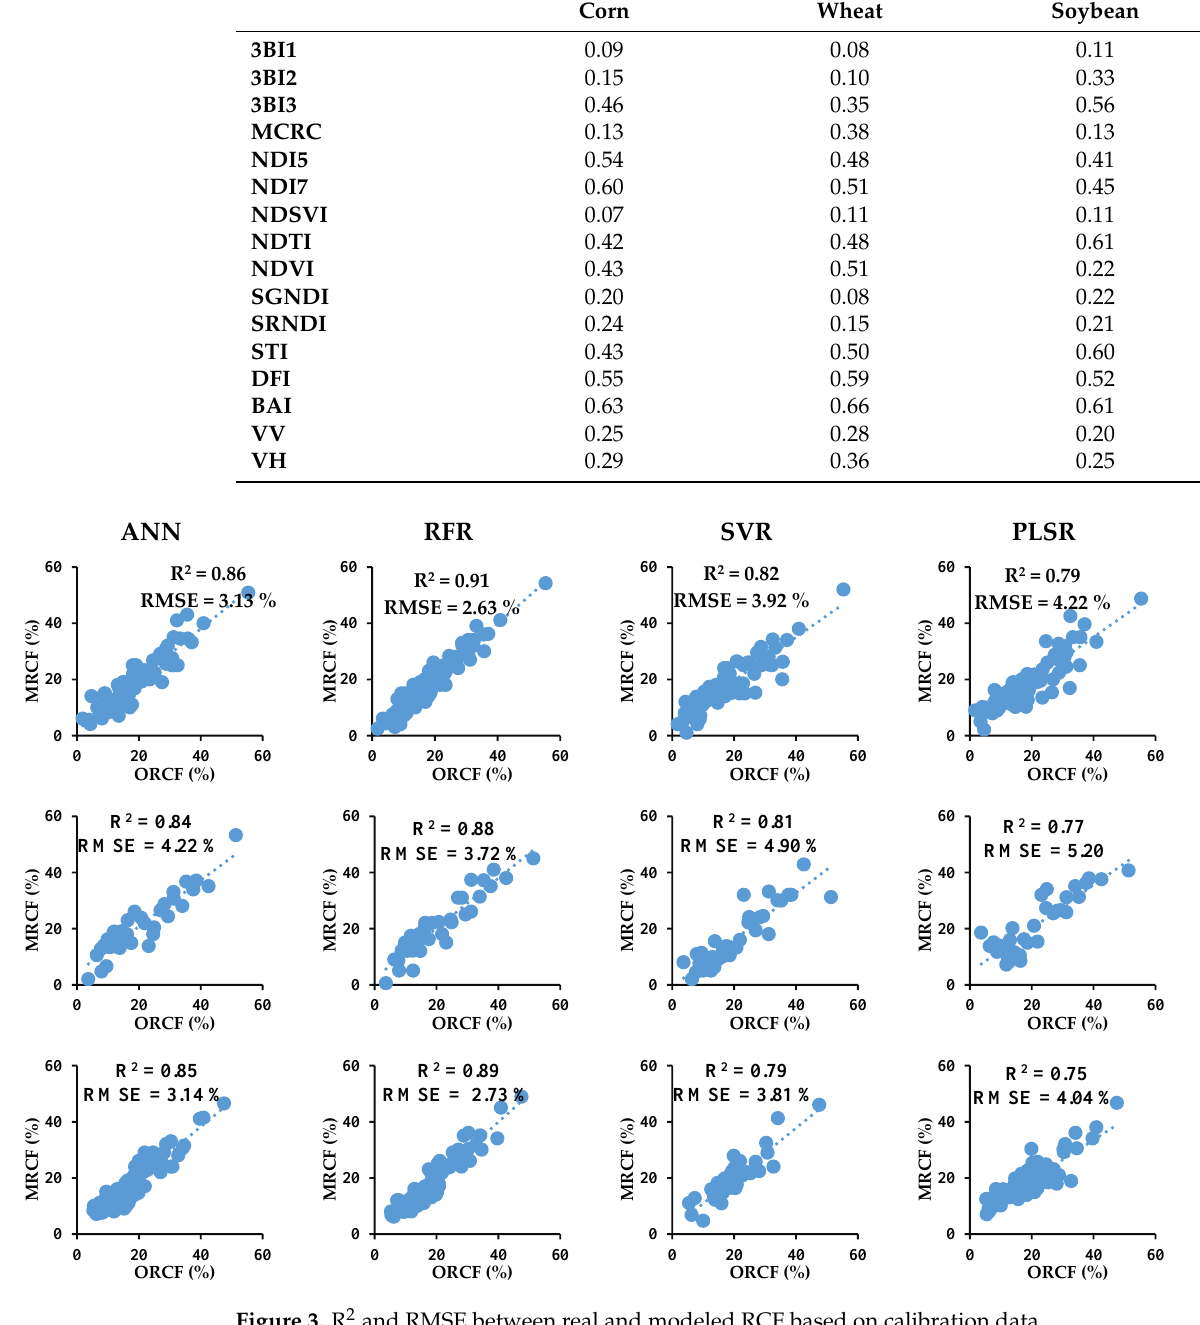
Figure 3. R 2 and RMSE between real and modeled RCF based on calibration data. For the validation data, the R 2 (RMSE) between the actual and modeled RCF based on ANN, RFR, SVR and PLSR algorithms for corn were 0.83 (3.89), 0.86 (3.25), 0.76 (4.56) and 0.75 (4.81%) (Figure 4). These values were 0.81 (4.86), 0.85 (4.22), 0.78 (5.45) and 0.74 (6.20%) for wheat and 0.81 (3.96), 0.83 (3.38), 0.76 (5.01) and 0.72 (5.65%), respectively, for